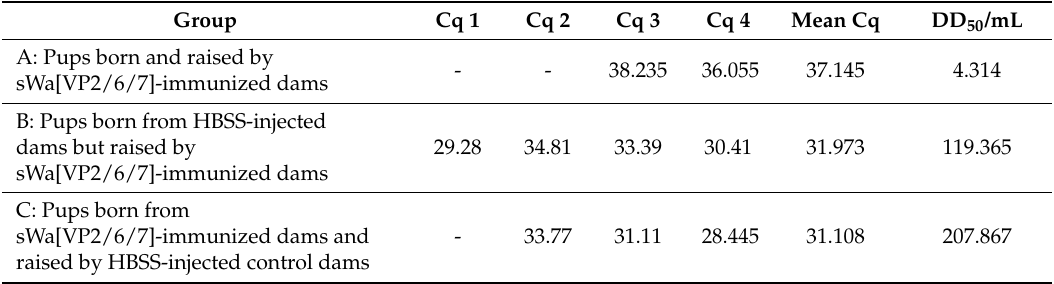
Table A10. This table shows the quantification cycle (Cq) values of pooled serum samples of pups analyzed by RV-specific RT-qPCR.